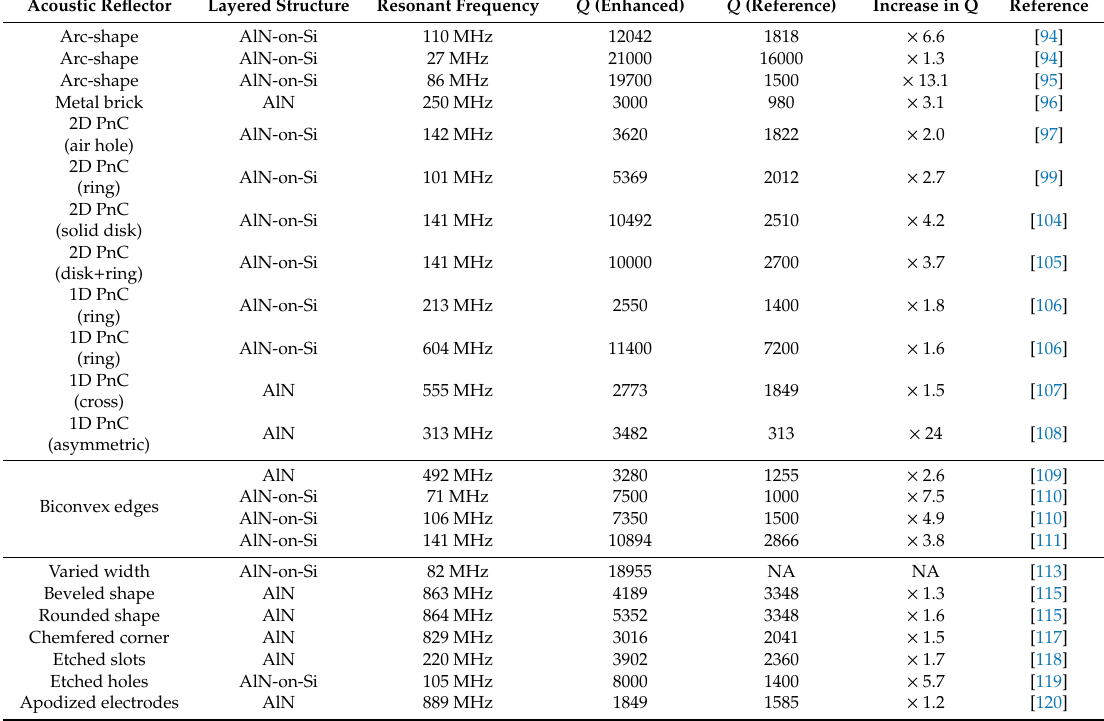
Table 1. Summary of Q-enhancement strategies for reducing anchor loss in